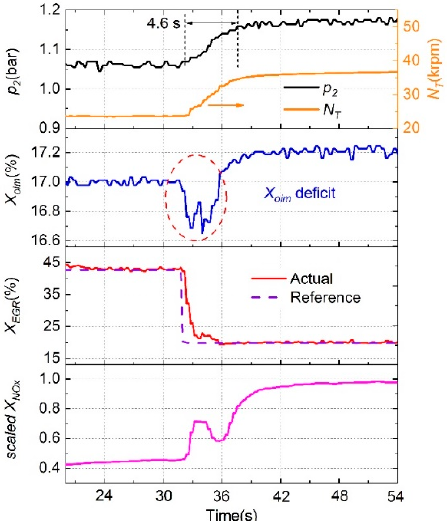
Figure 10. Tip-in test for the nominal system without assist.